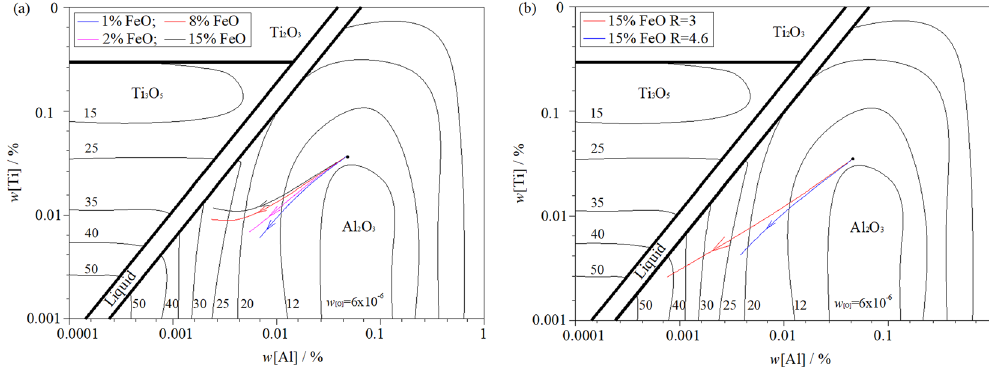
Figure 7. Effect of initial slag chemistry composition and basicity on change in [Al] and [Ti] in ultra- low carbon steel: ( a ) different chemical composition, same basicity; ( b ) different basicity, same chemical